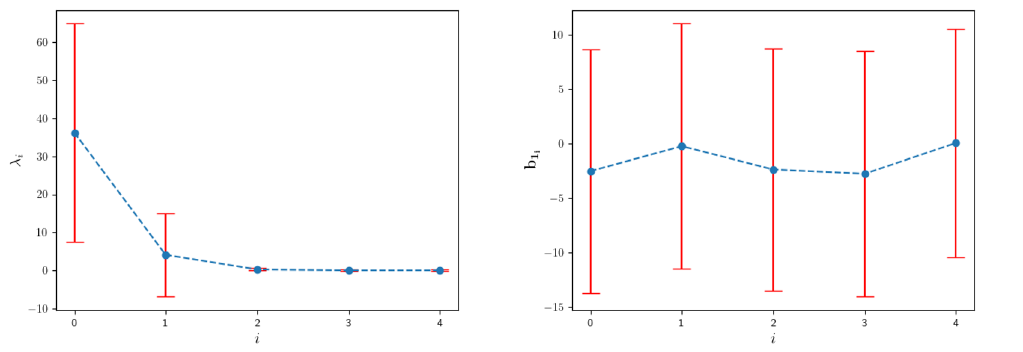
Figure 14 . (Left) Eigenvalues of the matrix ( W 1 ) T W 1 , with W 1 being the weight matrix of the first layer, averaged over 100 runs. (Right) The bias vector b 1 of the first layer, averaged over 100 runs. Error bars mark standard